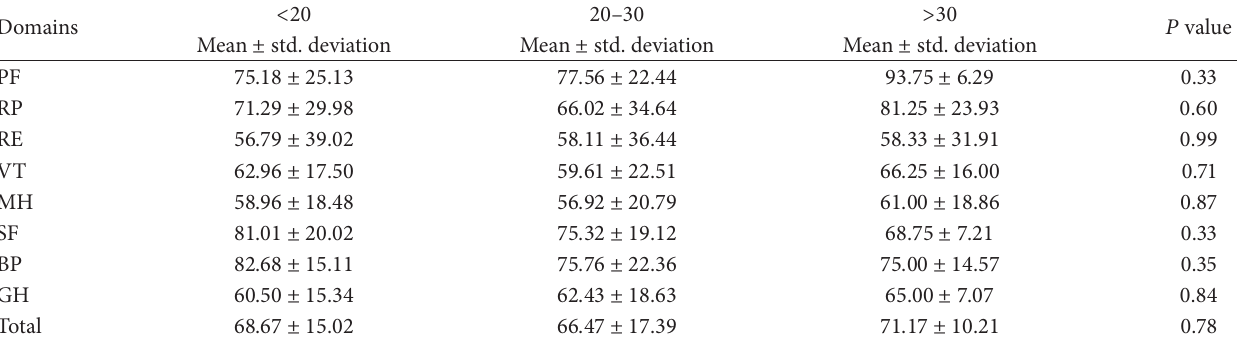
Table 2: Comparison of mean score of QOL (SF36) in different domains in patients with acne vulgaris with respect to age using ANOVA. < 20 20–30 Domains Mean ± std. deviation